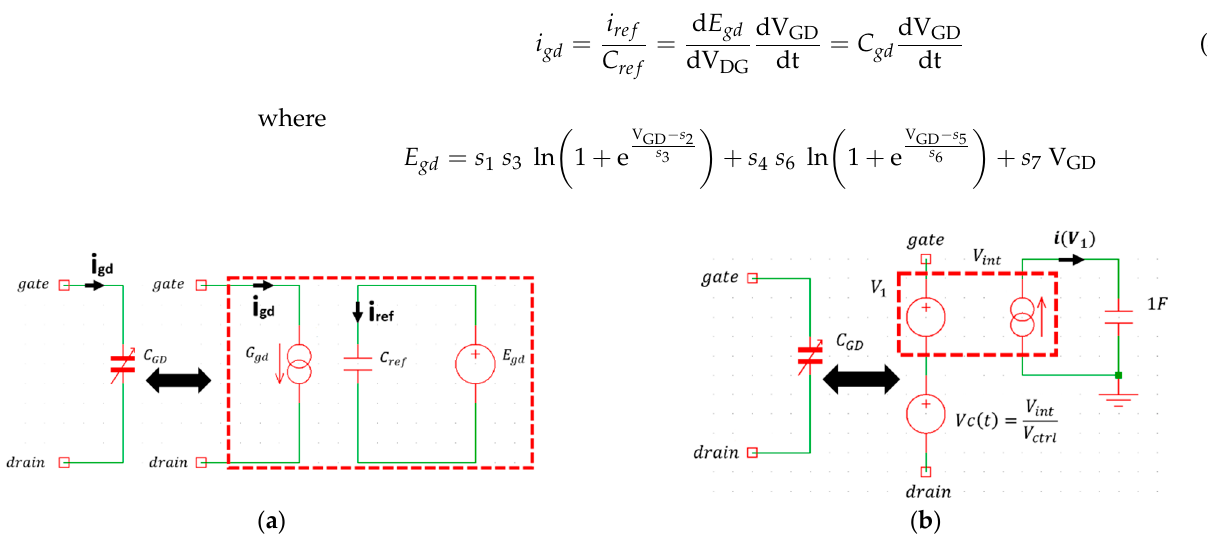
Figure 16. Parasitic capacitance implementations: ( a ) in [80]; ( b ) in